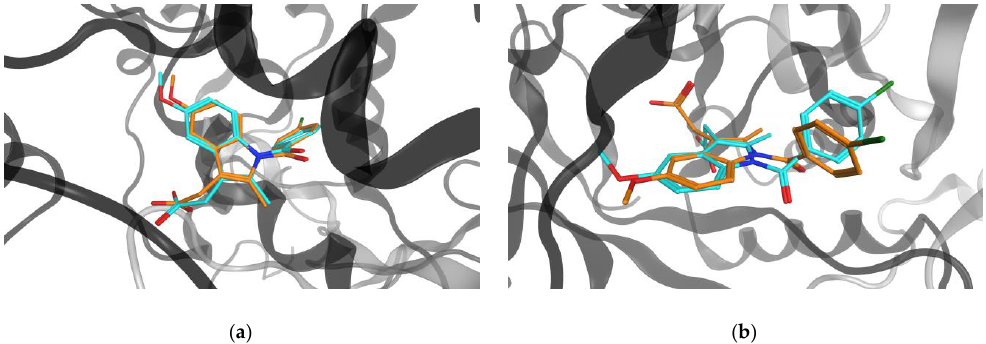
Figure 8. Indomethacin bound to di ff erent targets. Compared are binding modes of indomethacin in lactoylglutathione lyase (gray, PDB ID: 4KYK; LCs orange) and ( a ) prostaglandin G / H synthase 2 (black, PDB ID: 4COX; LCs cyan, shape similarity: 0.94) or ( b ) aldo-keto reductase 1_C2 (black, PDB ID: 4JQ4; LCs cyan, shape similarity: 0.68).